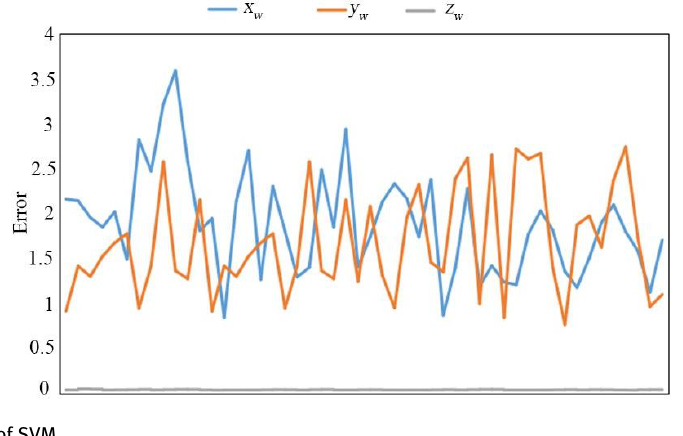
Figure 4: Error changes of SVM